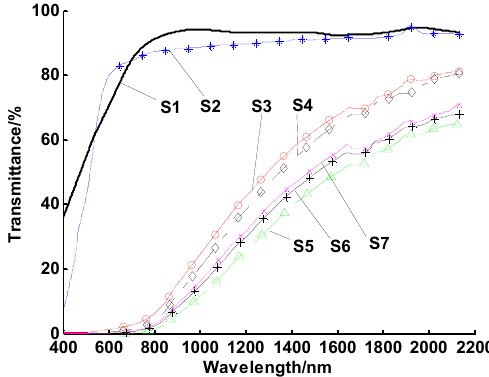
Figure 8. Spectral transmittances of CuO/oil nanofluids with different oleic acid volumes. Note: samples 1–7 had different oleic acid volumes from 0 mL to 1.5 mL with a 0.25 mL interval, respectively.